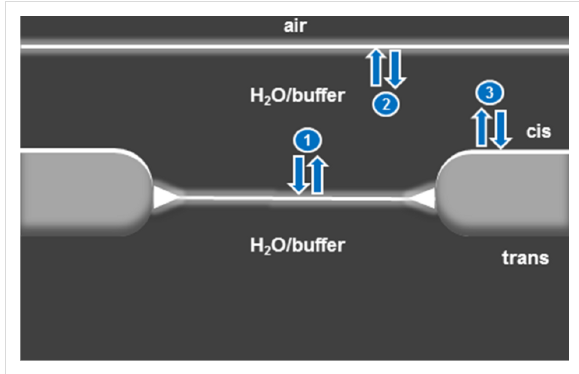
Figure 4: Schematic display of the three main equilibria existing on the cis side of the bilayer chamber.